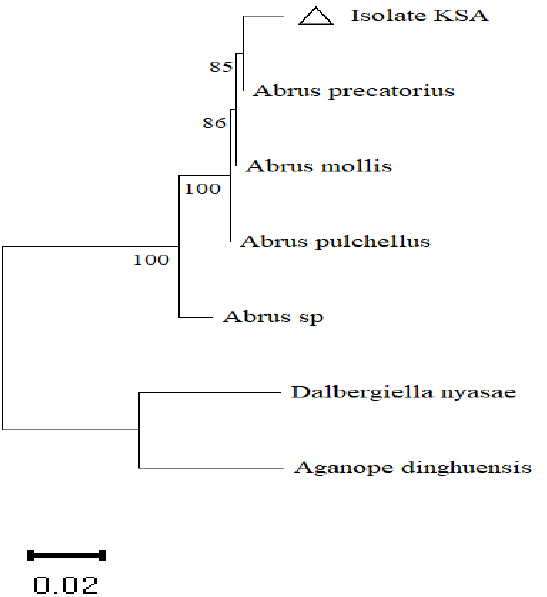
Figure 1. Identification of Abrus precatorius through the amplification of the internal transcribed spacer (ITS) region. Phylogenetic tree was constructed using MEGA X software and neighbor-joining methods by bootstrapping 1000 times. Scale bar: 0.02 substitutions per nucleotide.